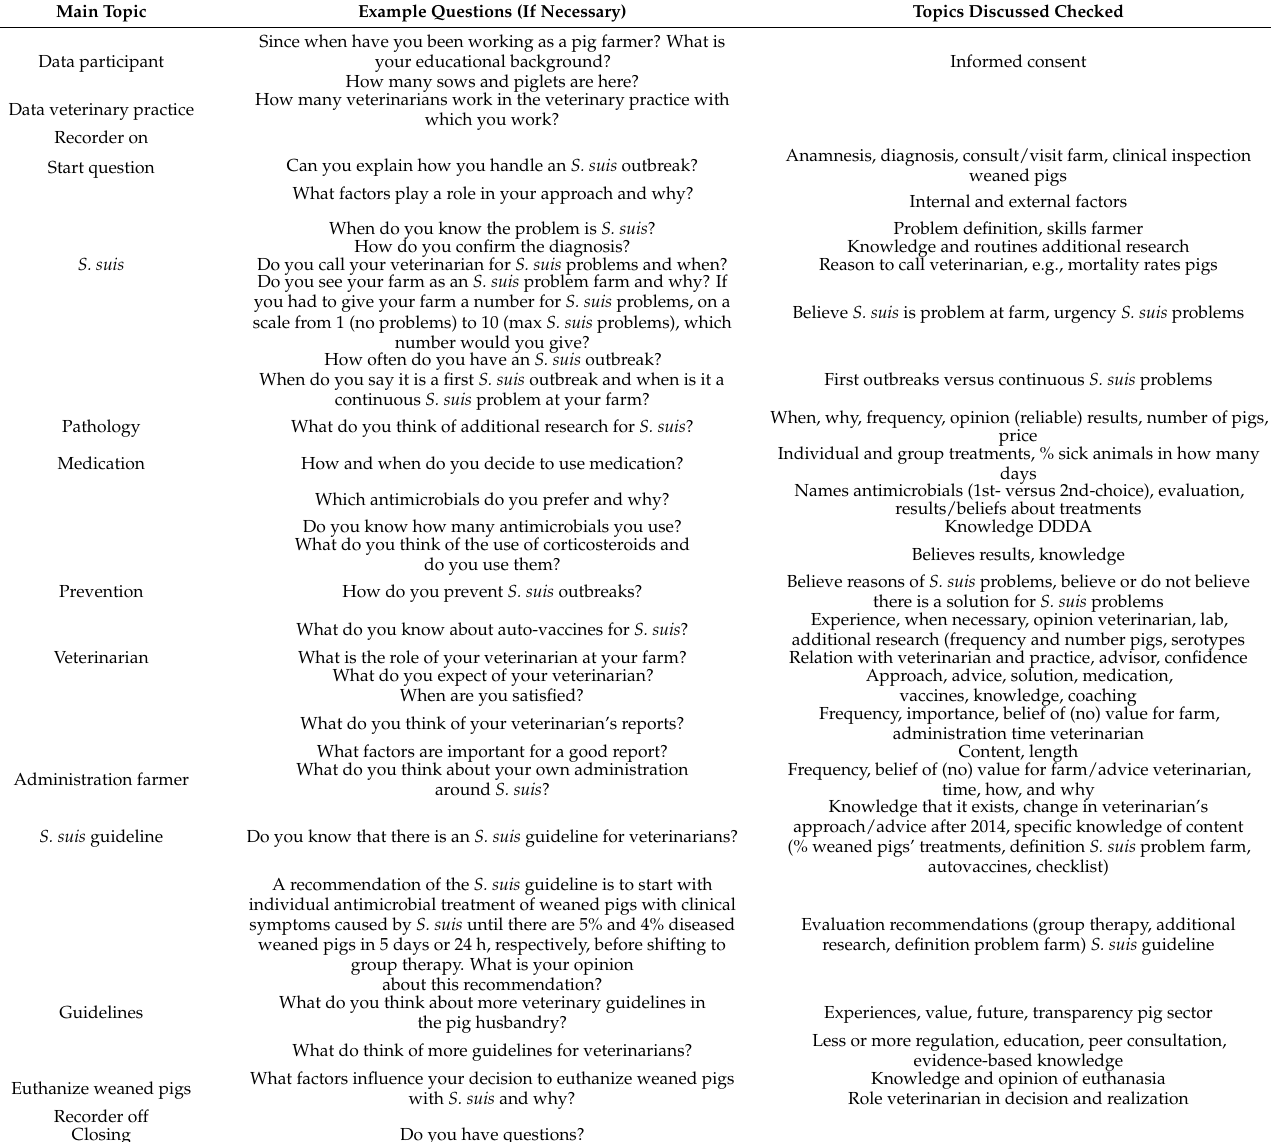
Table A2. Interview guide pig farmers in the study: “Why Veterinarians (Do Not) Adhere to the Clinical Practice Streptococcus suis (S. suis) in Weaned Pigs Guideline: A Qualitative Study”. Main research question: what factors influence the veterinarian in the decision-making process regarding (non) adherence to the S. suis guideline? The interview guide is translated from Dutch to English.